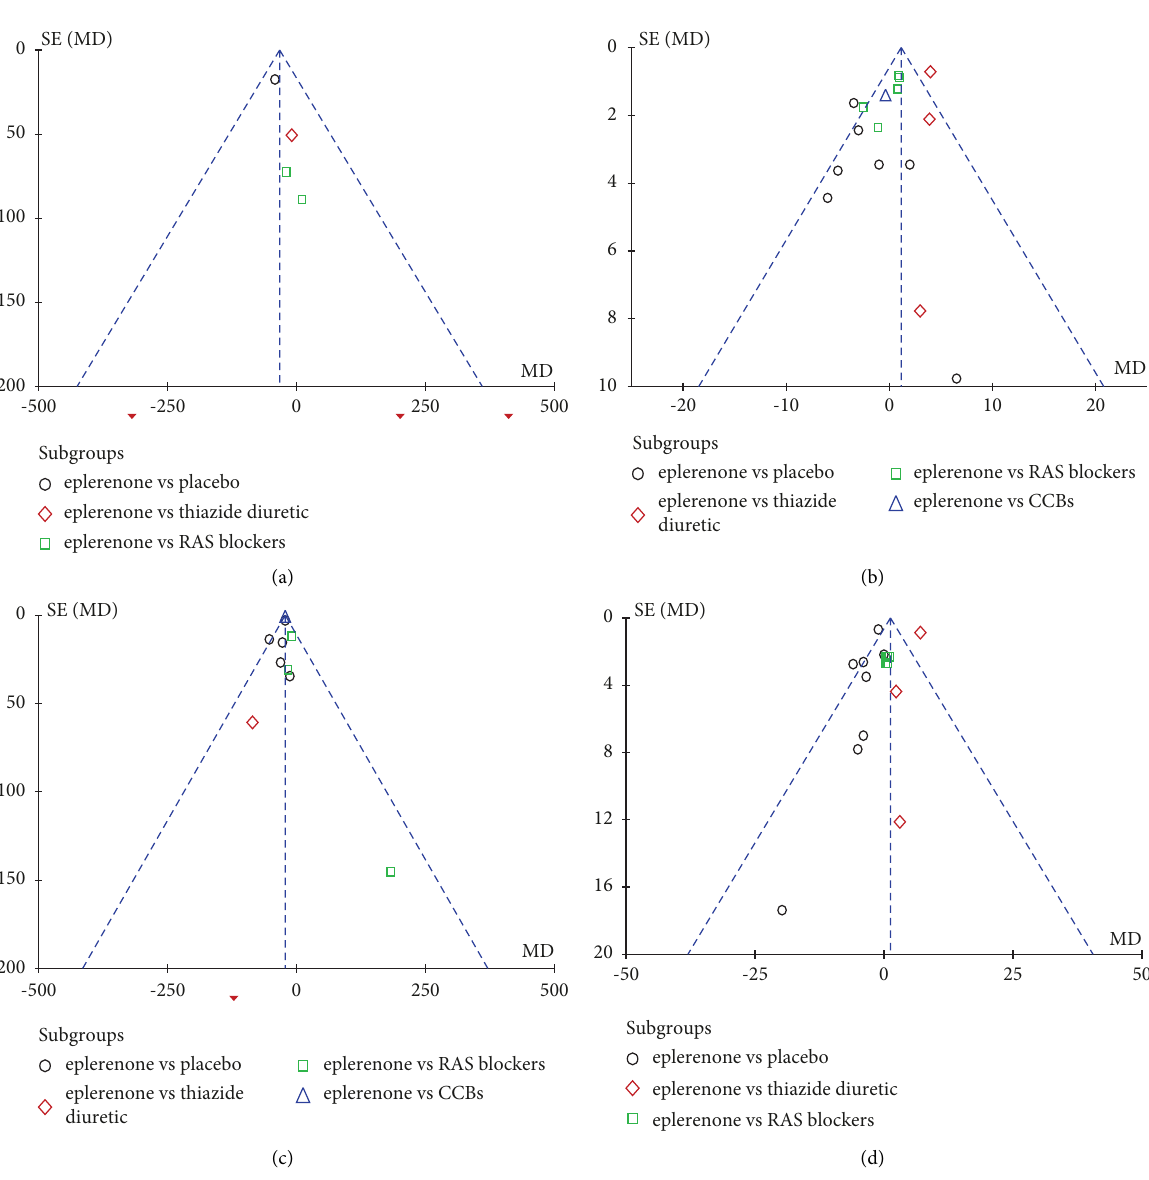
Figure 8: Funnel plots of the efects of eplerenone treatment on (a) 24-h proteinuria. (b) Systolic pressure. (c) UACR. (d)